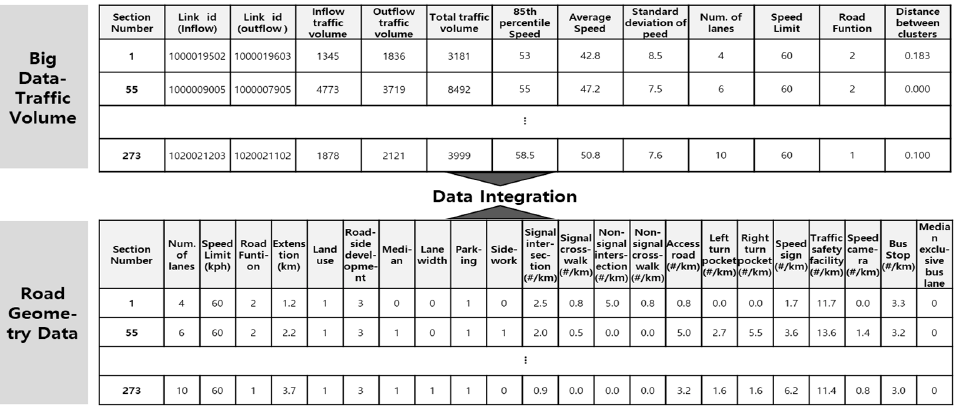
Figure 5. Big data integration and parameter setting.